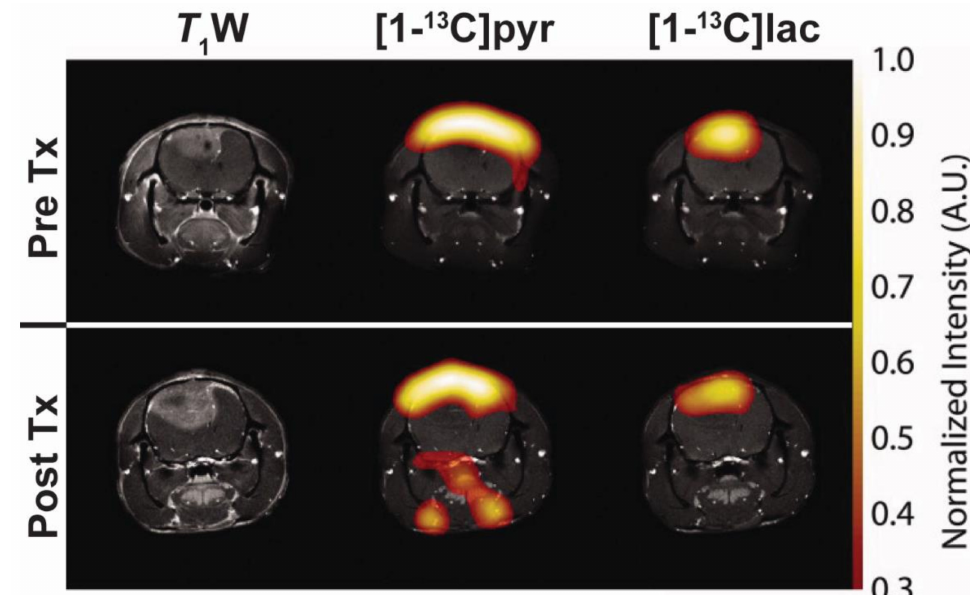
Figure 6. Representative images following injection of hyperpolarised (1- 13 C)pyruvate in a C6 glioma-bearing rat before (top, PreTx) and 96 h after radiotherapy (bottom, PostTx). Images of (1- 13 C)pyruvate ((1- 13 C)pyr) and (1- 13 C)lactate ((1- 13 C)lac) overlaid on coronal T 1 W MR images. A reduction in (1- 13 C)lactate production was observed in all tumours after 15 Gy irradiation without decreases in tumour volume. Adapted with permission from Day et al.